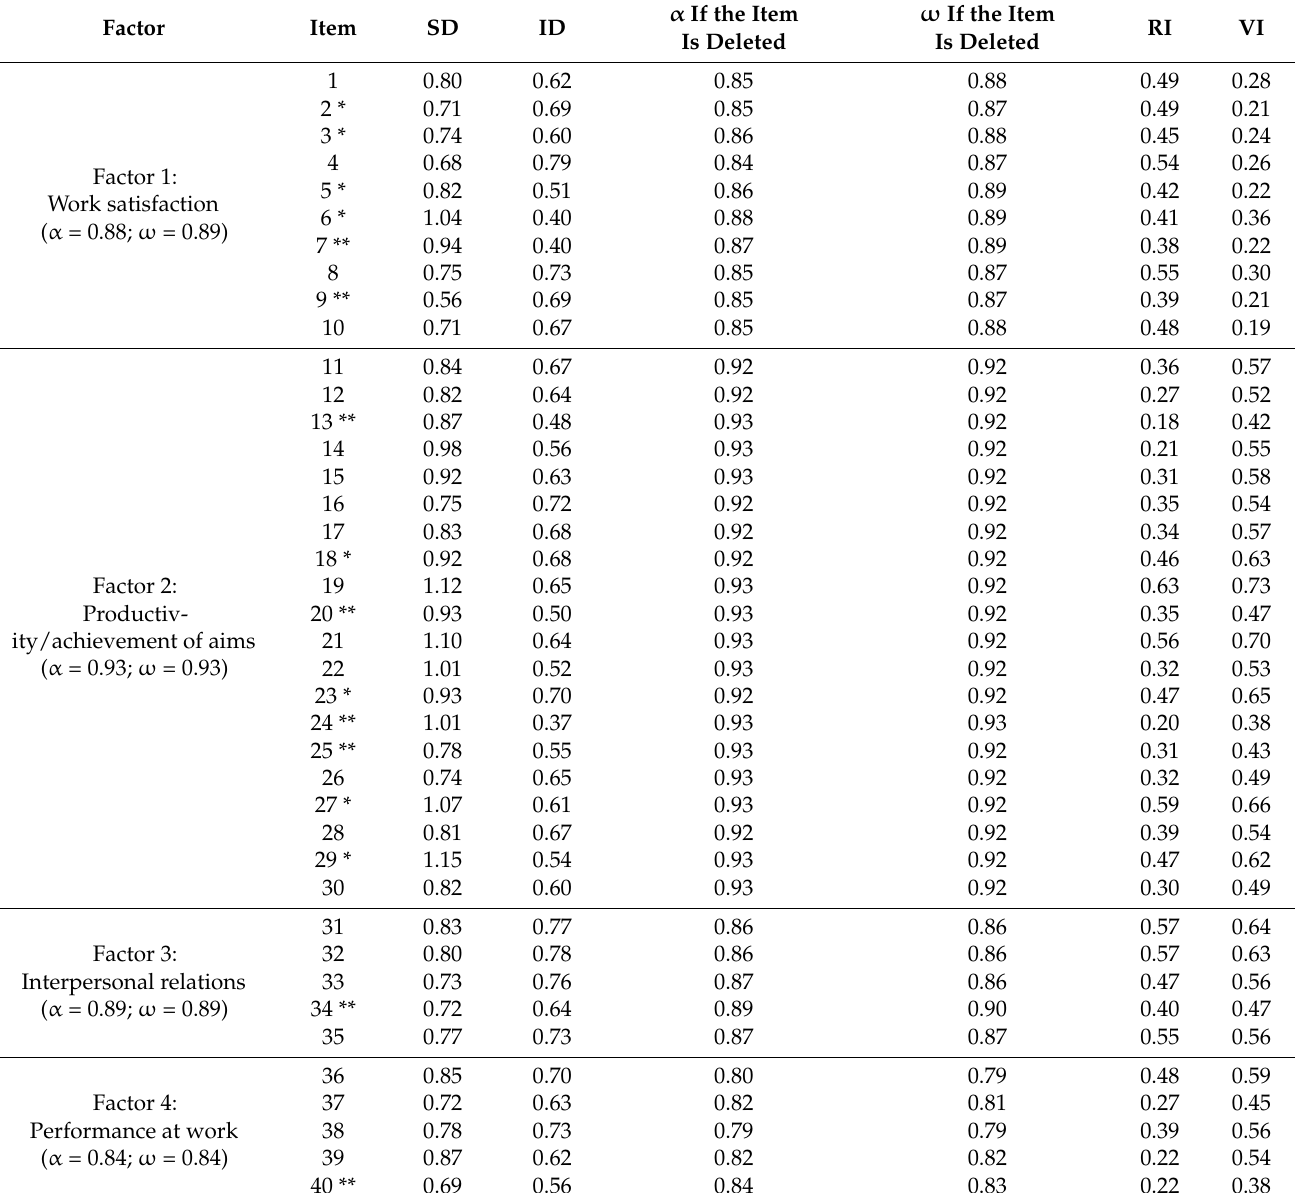
Table 3. Descriptive analysis of items presenting DIF eliminated during the iterative